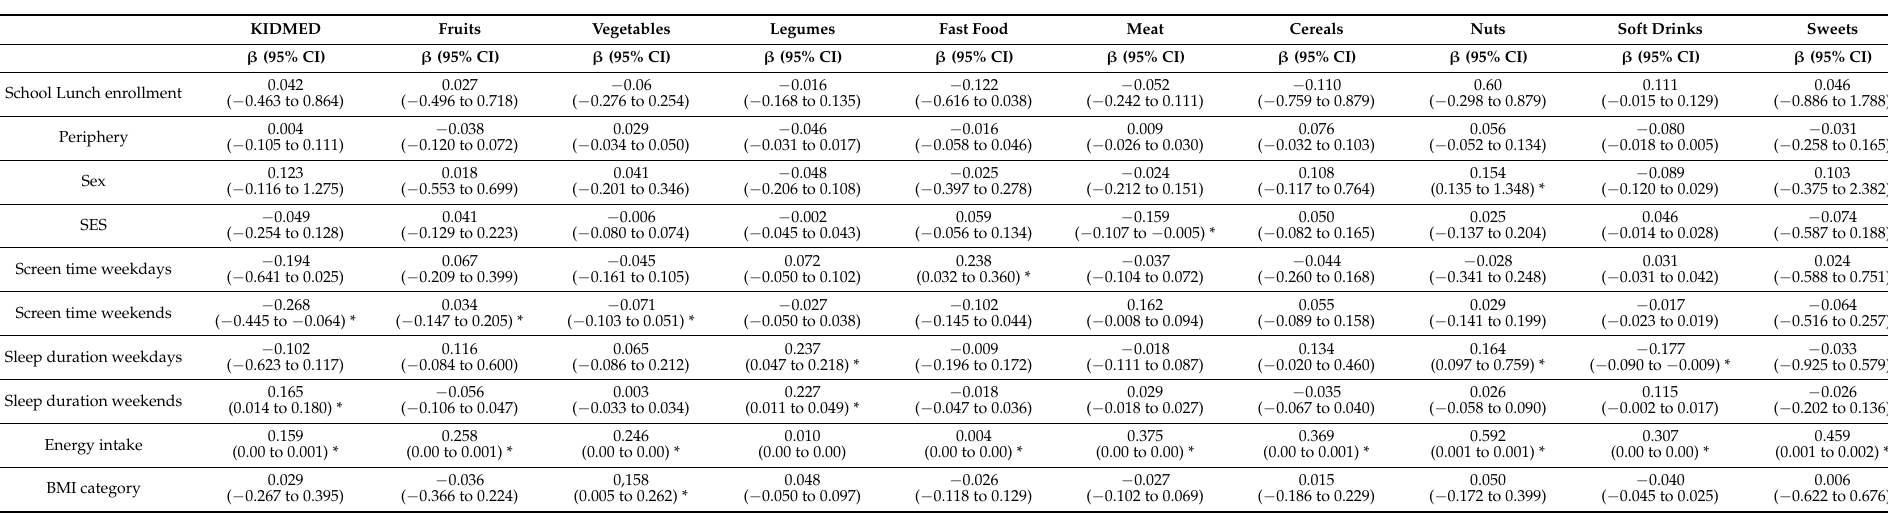
Table 5. Linear regression models to evaluate sociodemographic, anthropometric, and dietary habits factors with KIDMED and food categories consumption.